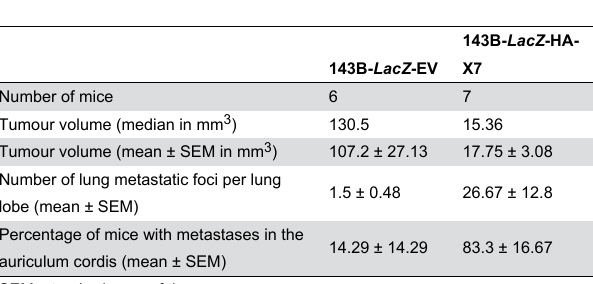
Table 1. Total number of mice per experimental group and characteristics of primary tumors and metastatic